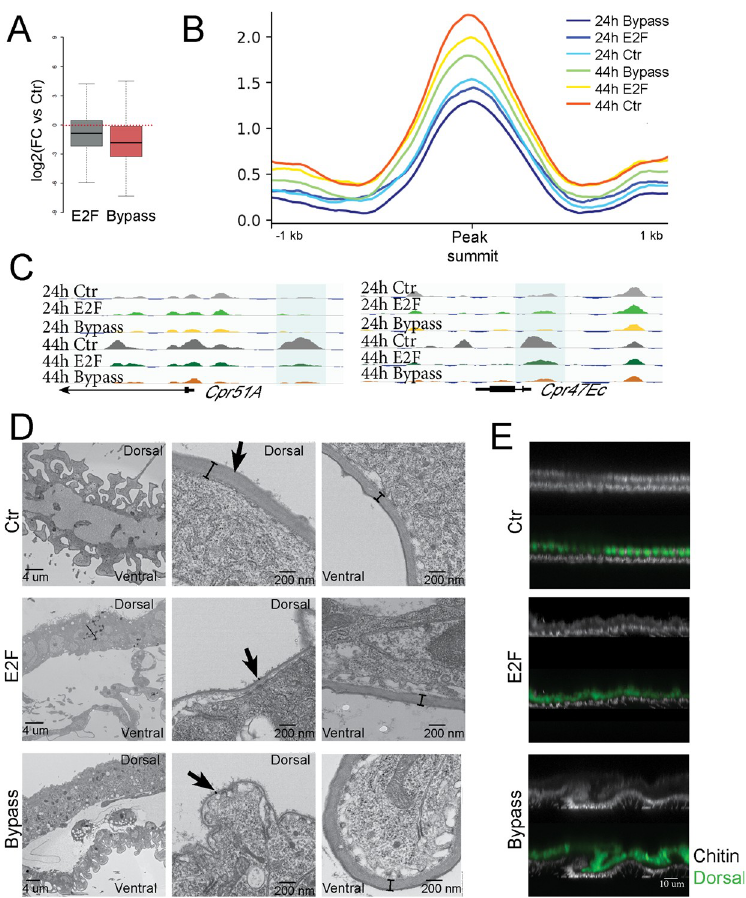
Fig 5. Compromising cell cycle exit impacts chromatin accessibility and gene expression at a subset of wing terminal differentiation genes. (A) log2 fold changes in RNA and (B) line plots of average FAIRE signal for genes involved in cuticle formation and differentiation. Preventing cell cycle exit reduces their expression and chromatin accessibility (E2F + CycD/Cdk4 at 44 h, p -value = 0.0046, Mann-Whitney U Test). (C) Selected cuticle protein genes exhibiting a failure to open potential regulatory elements at 44 h when cell cycle exit is delayed or bypassed. (D, E) Representative TEM (D) and chitin staining (E) of 64-h wings that delayed or bypass cell cycle exit in the dorsal wing epithelium using Apterous -Gal4/Gal80 TS to activate E2F or E2F + CycD/Cdk4 expression during the final cell cycle. Extracellular matrix formation and chitin deposition are disrupted when cell cycle exit is compromised. The underlying data in Fig 5A can be found within S5 Data. Cdk, cyclin-dependent kinase; Cpr, Cuticular protein; Ctr, control; CycD, Cyclin D; E2F, E2F transcription factor; FAIRE, formaldehyde-assisted isolation of regulatory elements; FC, fold change; Gal80 TS , temperature-sensitive Gal80; TEM, transmission electron